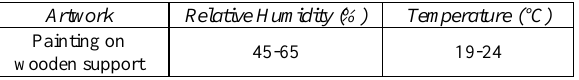
Table 1. Thermo-Hygrometric parameters for the conservation of optimal chemical and physical conditions of artworks. The most used specifications for indoor climate control in Italian museums are contained in the Italian standard UNI 10829:1999 (Mibac, 1999). According to these guidelines the optimal thermo-hygrometric parameters for the conservation of paintings on wooden support are shown in shown in Table